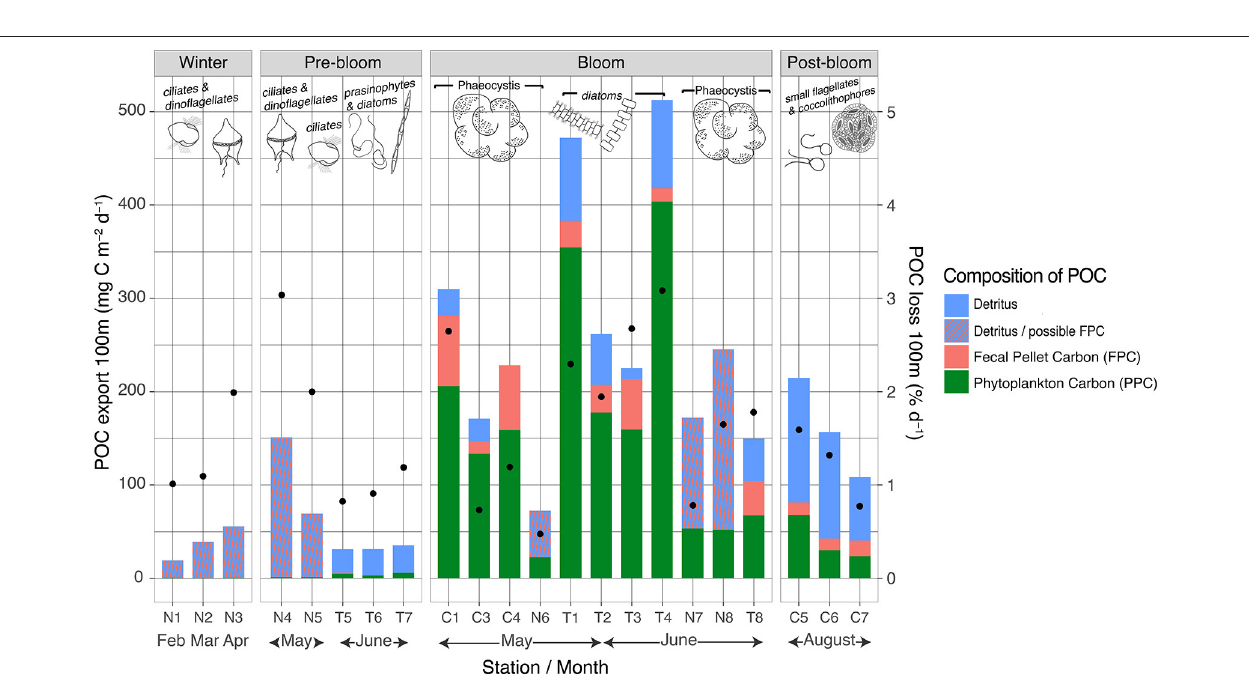
FIGURE 8 | Vertical POC export at 100m depth including composition (bars, absolute values stacked) and the daily POC loss rates for each station (black dots). Note that “detritus/possible FPC” represents those stations where FPC samples were unavailable for analyses and that the “C” stations were sampled in 2014 and the “N” and “T” stations in 2015. The drawings over the bars represent the dominant protist groups in the upper water column at each station.